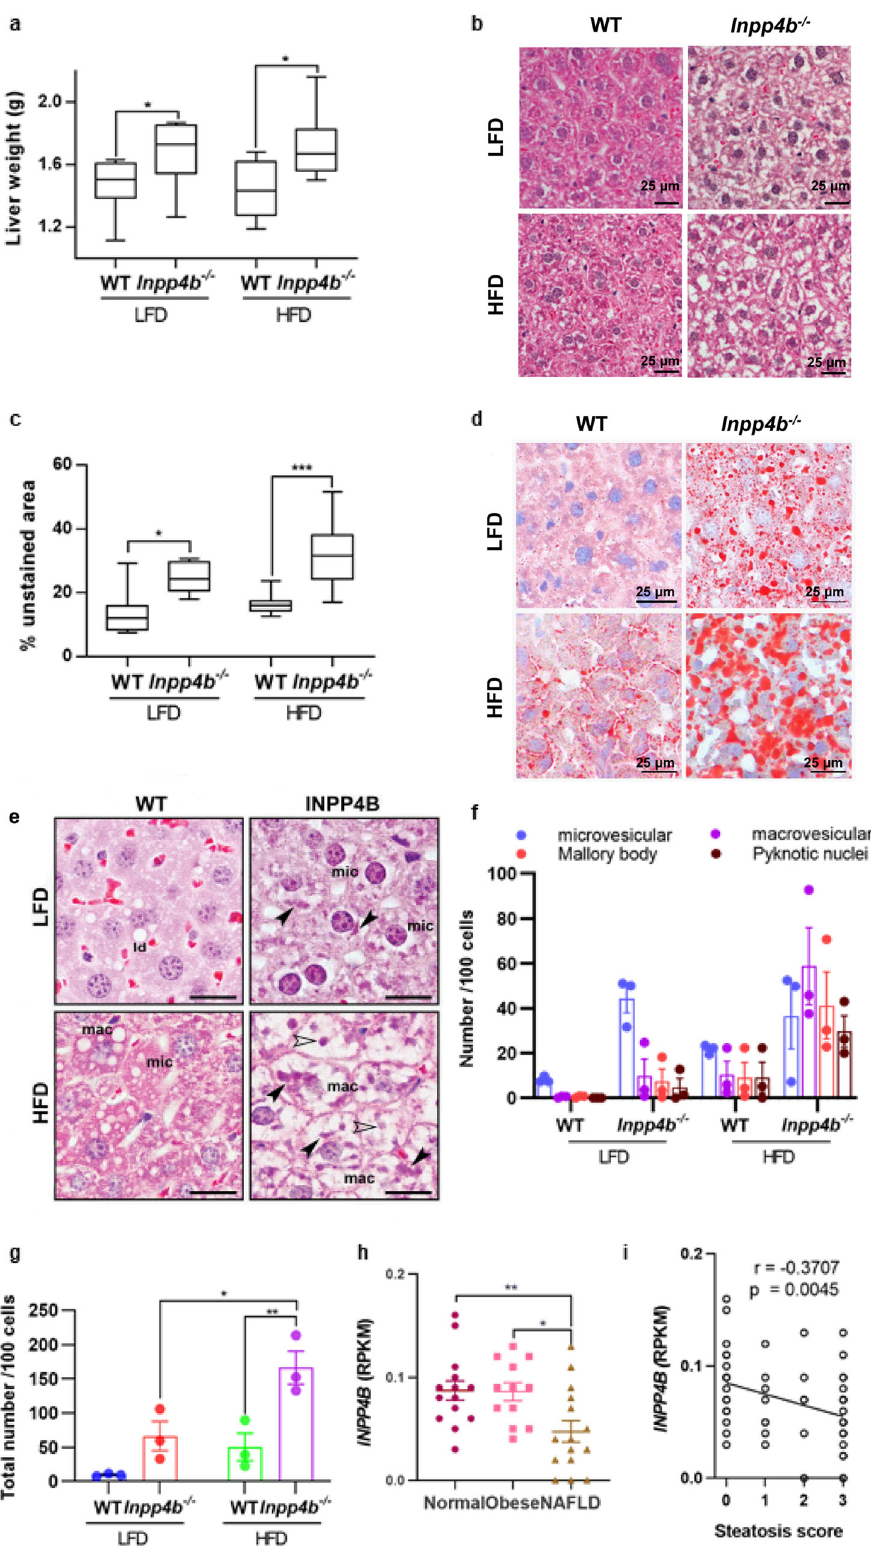
and mutant males, there was no difference between the two genotypes in Cd68 expression (Supplementary Fig. 7e). In fl am- matory in fi ltrate was observed in the prostate stromata of obese WT and knockout males (Supplementary Fig. 7f, marked with * ). Staining with the Ki67 antibody indicated increased cellular proliferation in the prostates of HFD Inpp4b − / −